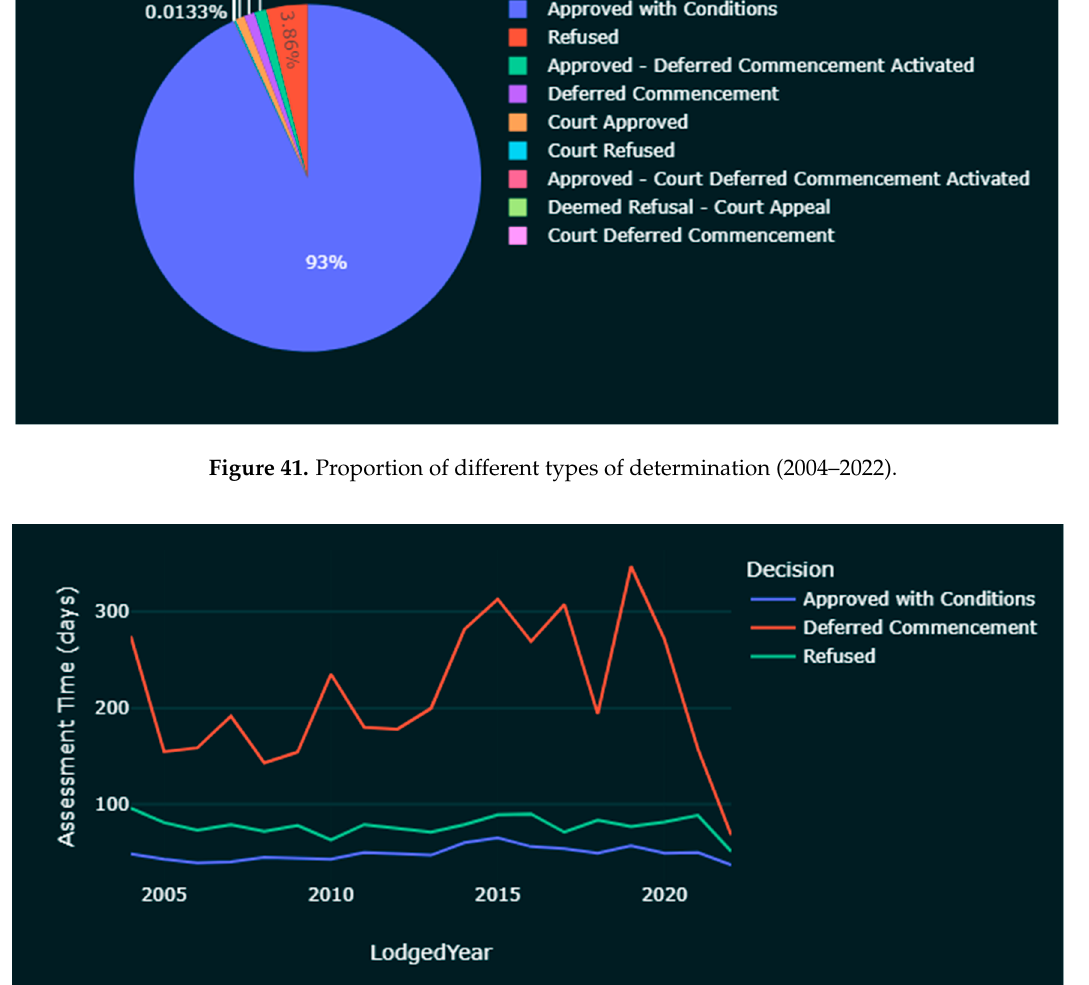
Figure 42. Annual median assessment time by decision type (2004–2022).